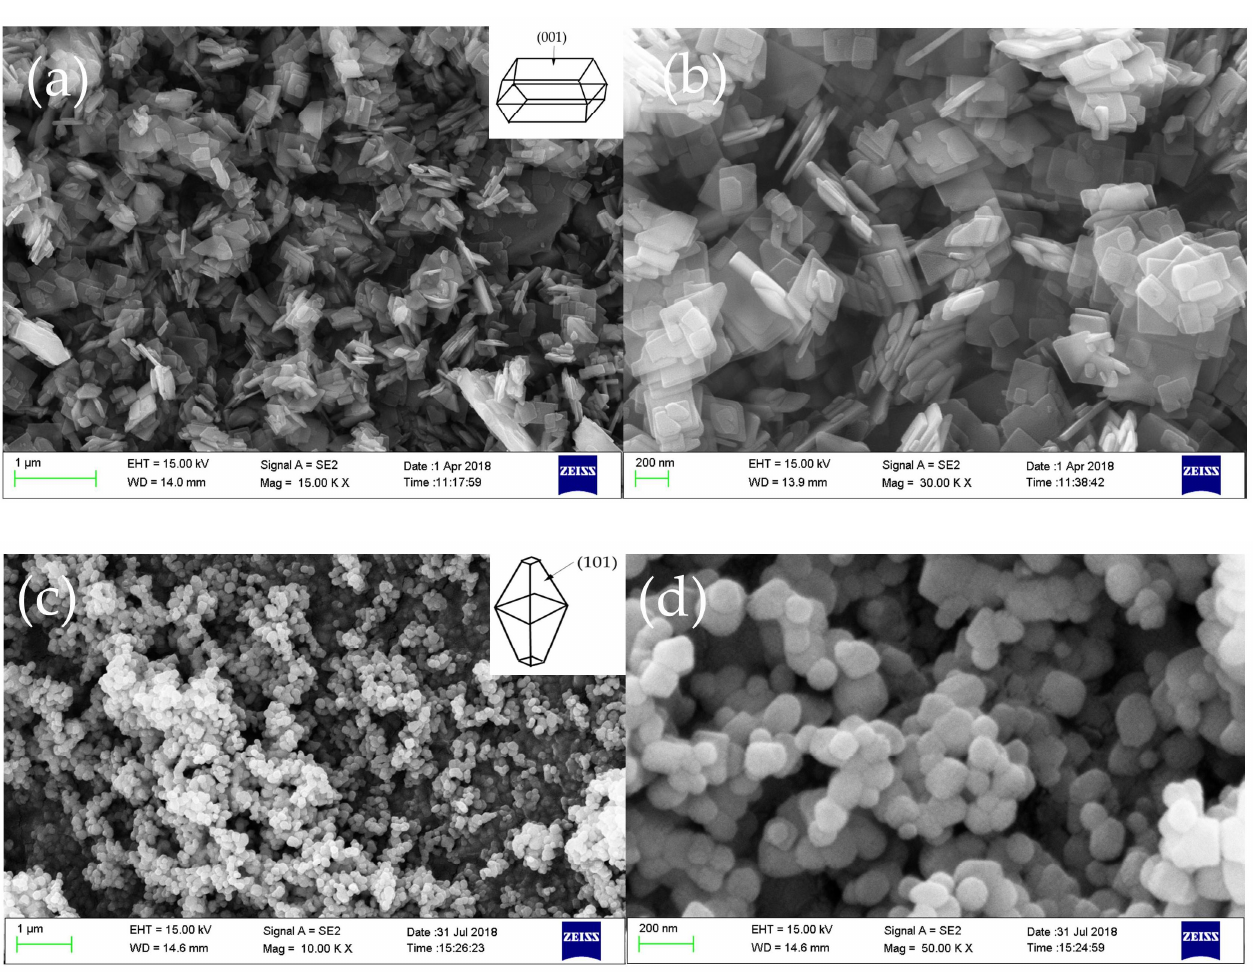
Figure 2. SEM of anatase (TiO 2 ) with exposed (001) facets ( a , b ) and anatase (TiO 2 ) with exposed (101) facets ( c , d ).